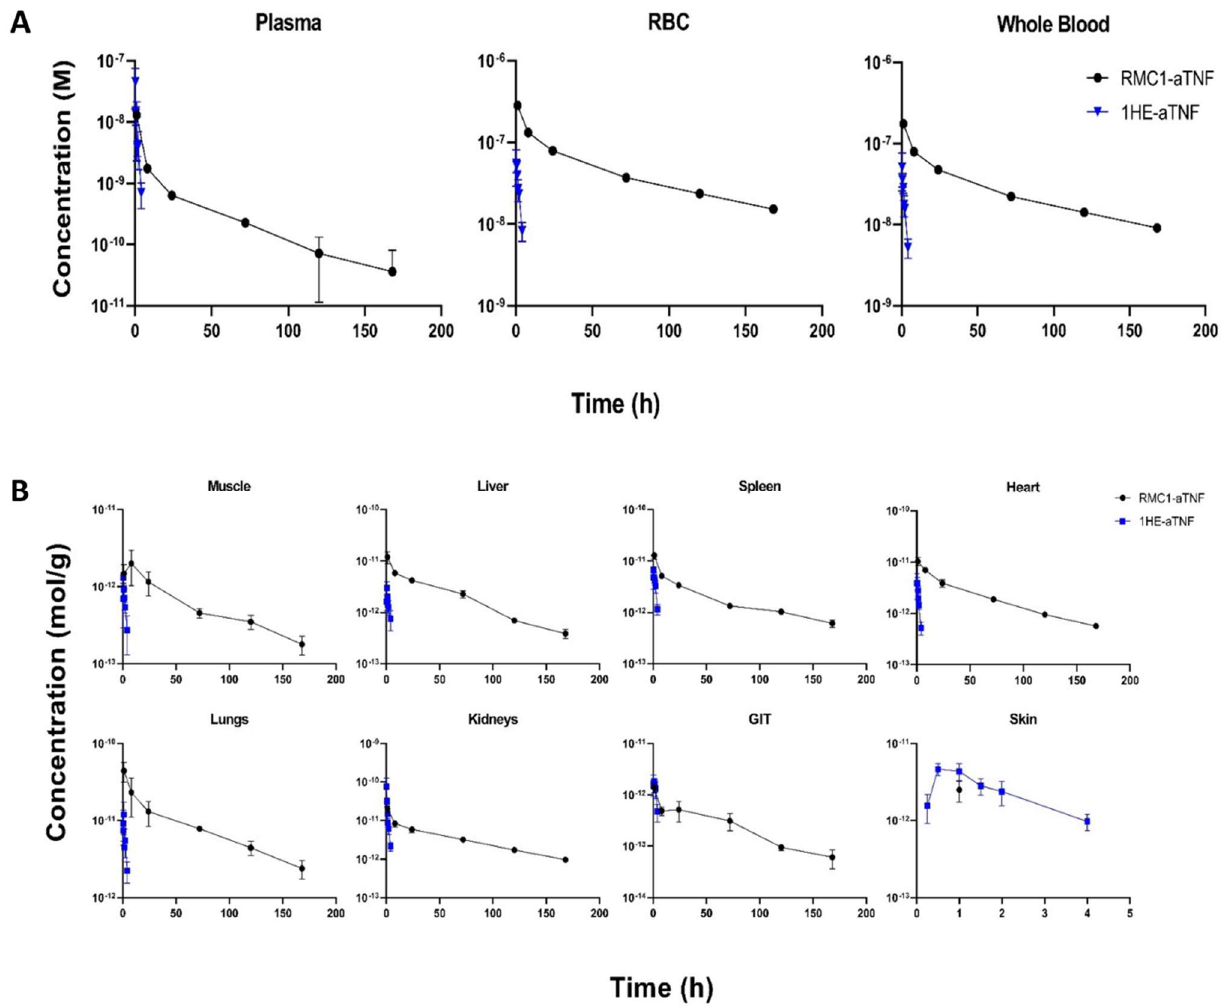
Figure 5. Pharmacokinetics and biodistributions of anti-RBC-TNFα bispecific sdAb fusion protein (RMC1-aTNF) in mice. ( A ) The systemic concentration-time profiles after an IV administration of 1 mg/kg of RMC1-aTNF and 1HE-aTNF with a tracer dose of 125 I labeled in plasma, RBC, and whole blood are shown. The plasma half-life of RMC1-aTNF was around 75 h, significantly longer than the control bispecific fusion protein 1HE-aTNF (1.3 h). ( B ) The concentration-time profiles of RMC1-aTNF and 1HE-aTNF control in tissues are shown. Data points represent the mean concentration ( n = 3), and error bars denote the standard deviation of the mean.